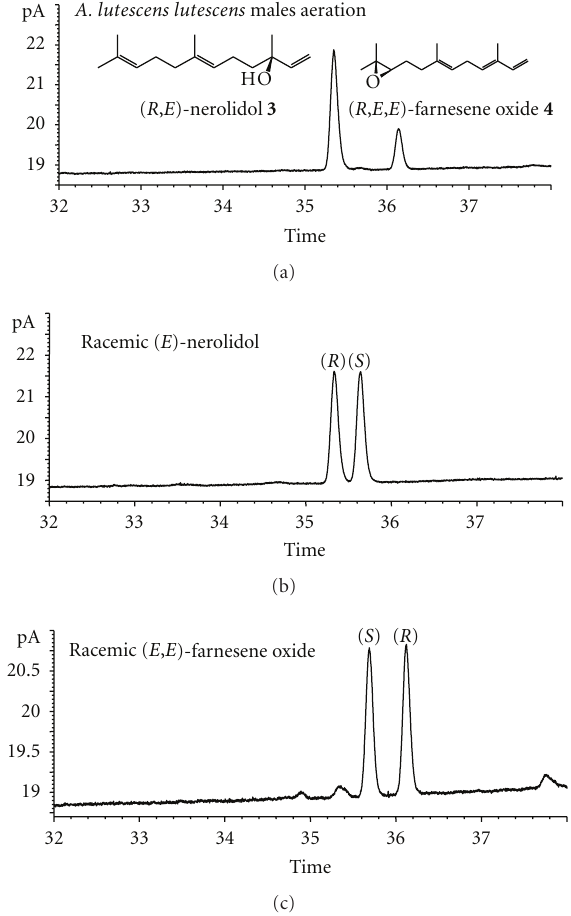
Figure 2: Sections of GC-FID traces of an aeration extract of male Amblypelta lutescens lutescens (a), racemic ( E )-nerolidol (b), and racemic ( E , E )-farnesene oxide (c). Column: Chiraldex B-DM (30 m × 0.25 mm i.d. × 0.12 μ m), 100 ◦ C (2min) to 180 ◦ C at 2 ◦